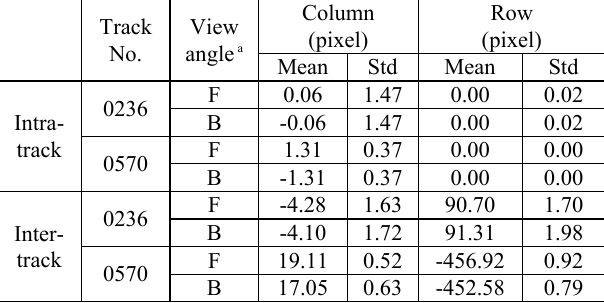
Figure 2. CE-2 DEMs generated (a) before and (b) after adjustment Table 1.Back-projection residuals before adjustment